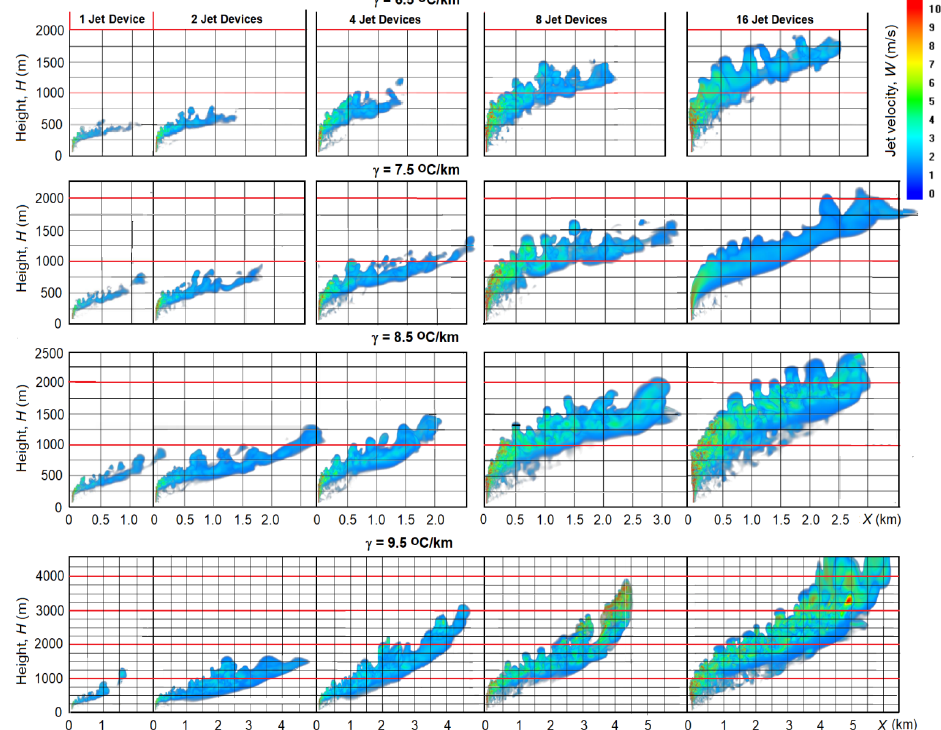
Figure 16. Vertical cross sections of the jet velocity field W (m/s) created by an experimental device consisting of 1, 2, 4, 8, and 16 turbojet engines D-30. Atmospheric conditions: vertical wind profile U = 1 + 0.005 h (m/s) ; temperature lapse rate γ = 6.5, 7.5, 8.5 and 9.5 °C/km, no inversion layers. It follows from Figure 17 that the height of the jet rise depends on the power of the turbojet engine (or the number of engines) to the power of 0.4, and not to the power of 0.25, as Vulfson and Levin [29] supposed.